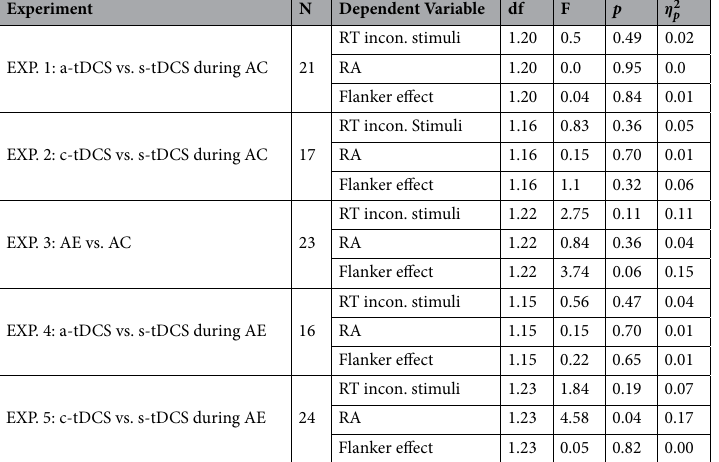
Table 1. Statistical key figures of the flanker task-related dependent variables. Only the values for Time × Condition interactions are shown. AC = active control, AE = aerobic exercise, RA = Response accuracy, RT = Reaction time